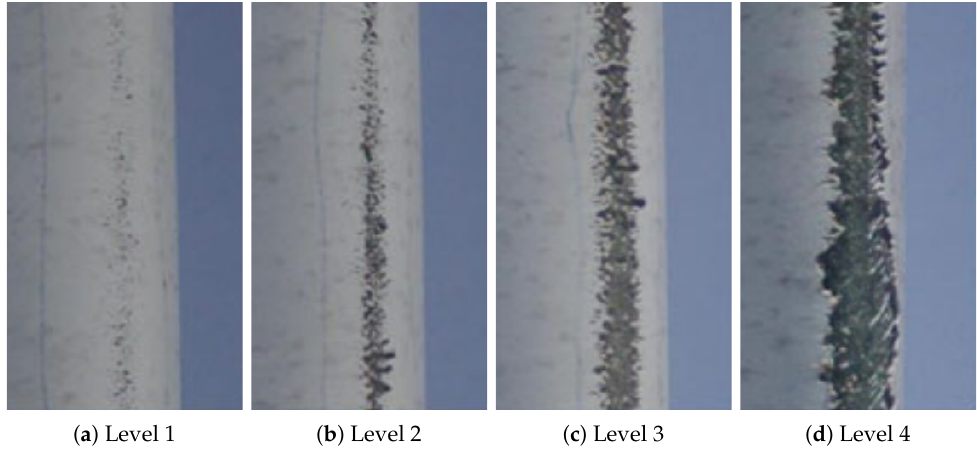
Figure 1. Various levels of erosion from lighter ( left ) to heavier ( right ), adapted from